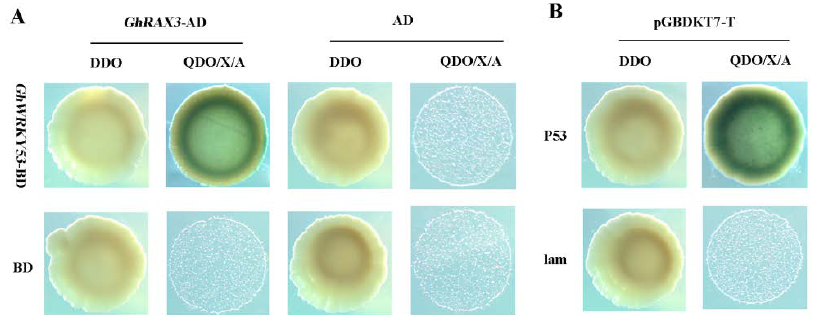
Figure 11. Yeast two-hybrid assay of GhWRKY53-GhRAX3 interaction. ( A ) Physical interaction of GhRAX3 with GhWRKY53 in yeast cells and the yeast co-transformed GhWRKY53 -pGBKT7 + GhRAX3-pGADT7 grown on SD-Trp-Leu-His-Ade/X- α -Gal/AbA (QDO/X/A) medium. ( B ) pGBKT7-P53 + pGADT7-T and pGBKT7-lam + pGADT7-T were used as positive and negative controls, respectively. The yeast co-transformed the positive control vector grown on SD-Trp-Leu-His-Ade/X- α -Gal/AbA (QDO/X/A) medium. GhWRKY53 -BD: GhWRKY53 -pGBKT7, GhRAX3 -AD: